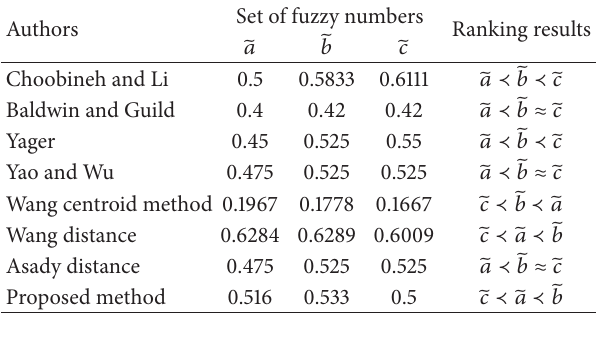
Table 2: Ranking results for the second set of fuzzy.